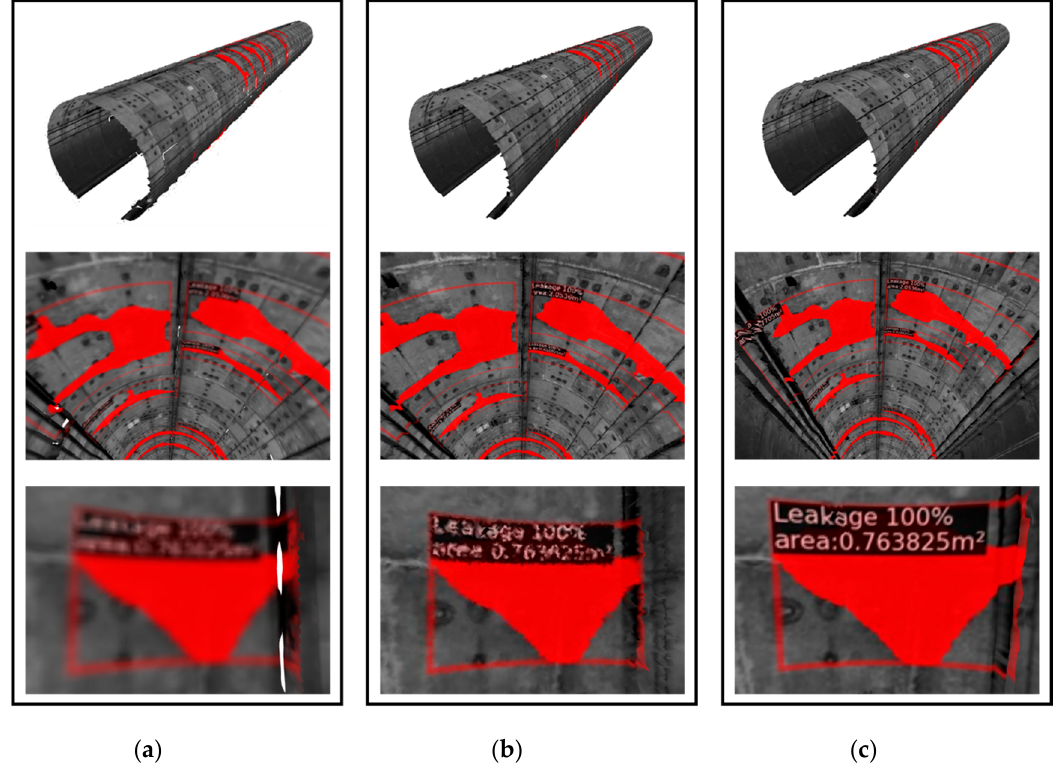
Figure 20. Results of tunnel reconstruction by different algorithms, including: ( a ) Poisson reconstruction, ( b ) Delaunay triangulation, and ( c ) the proposed method.